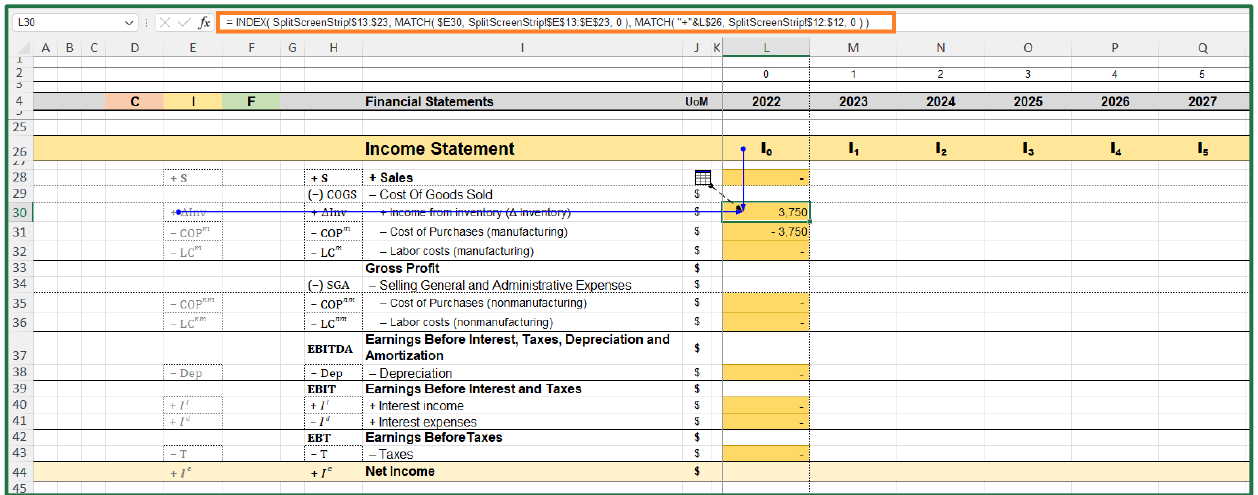
Figure 53. Cell L30 contains the formula for picking the inventory variation, + ∆ Inv, of period t = 0 (“ConventionalFinStat” sheet).